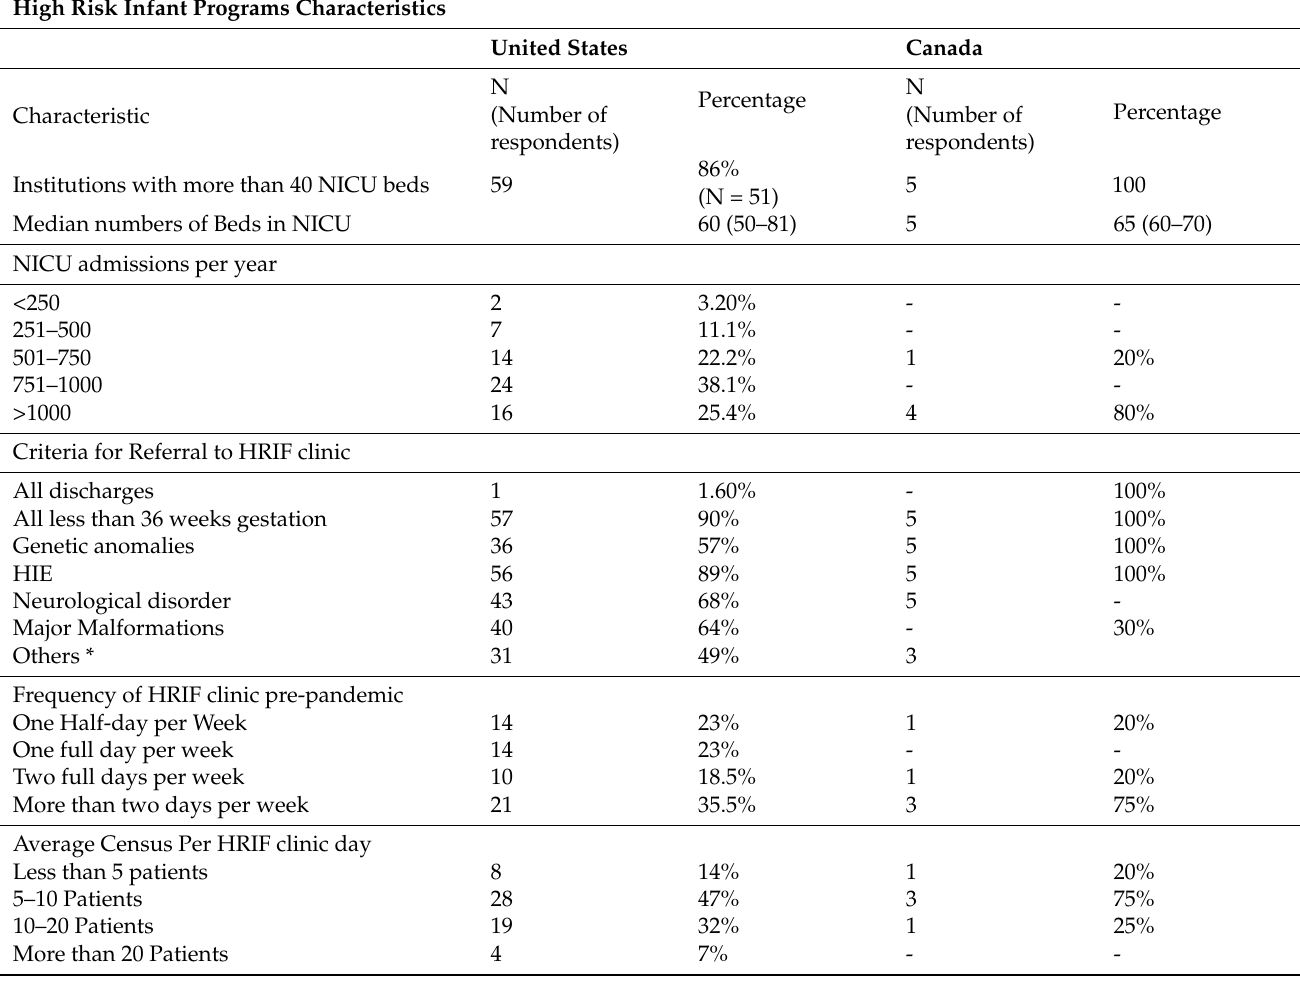
Table 1. Program